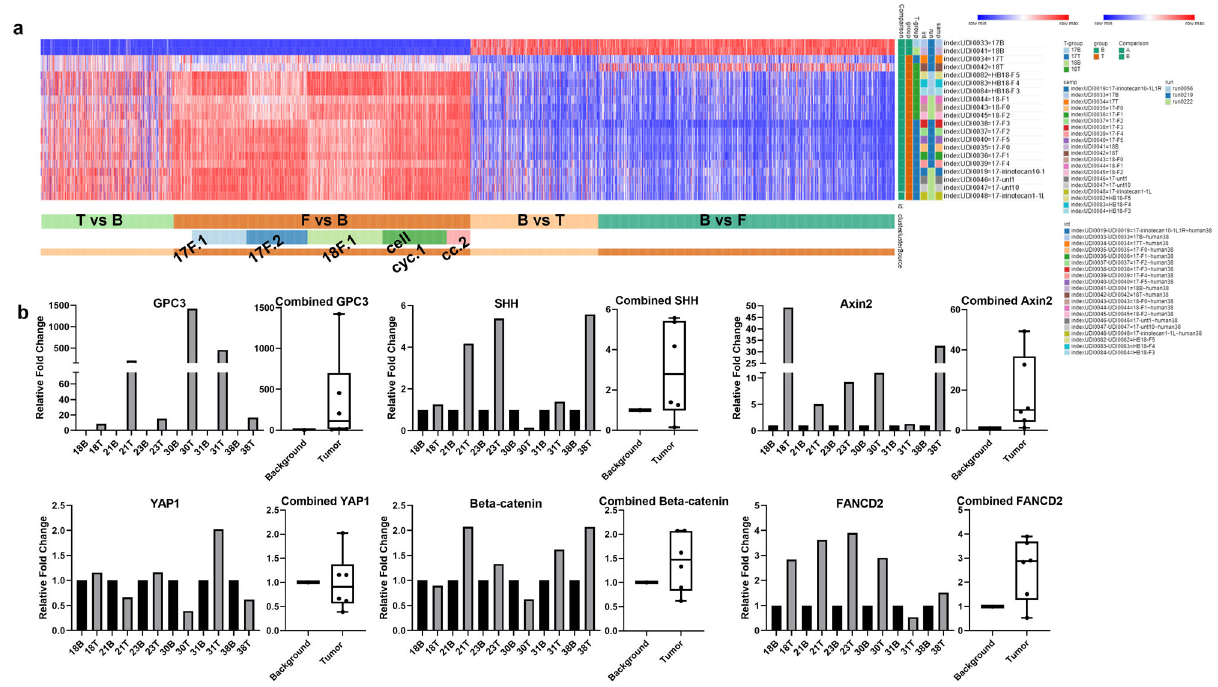
Fig. 2 RNAseq comparison of HB samples. a Heat map to demonstrate the expression differences between human background liver, source tumor, and PDX tumor over time (passages F0 – F5 demonstrate expansion of tumor through multiple sets of mice). Overexpressed genes in HB tumor are often overexpressed to a greater degree in PDX and genes with lower expression can demonstrate further reduction in PDX. PDX tumor maintains a similar gene expression pro fi le through multiple passages. b Validation of upregulation in genes of interest. qRT-PCR validation of gene expression in human HB background liver (B) compared with tumor (T). Each number — B/T represents matched samples from one patient. GPC3 is overexpressed in T vs. B. YAP1 shows some elevation in T, but expression is variable. SHH is generally overexpressed in T. Beta-catenin ( CTNNB1 ) is variable but generally has moderate elevation in T. AXIN2 and FANCD2 are elevated in many T samples and appear to correlate with PDX tumor-growth